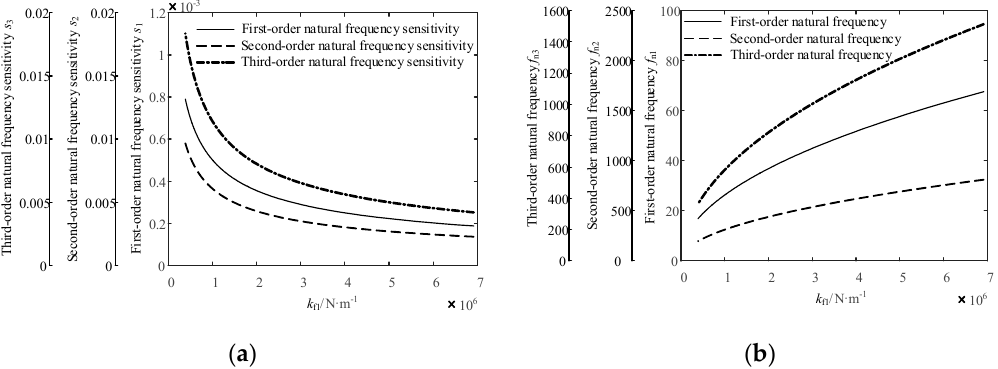
Figure 8. The variation law of the first three natural frequencies and their sensitivities of the jet system under a different initial gas content of the fluid with the stiffness of fluid unit 1. ( a ) Variation law of natural frequency sensitivity. ( b ) Variation law of natural frequency.